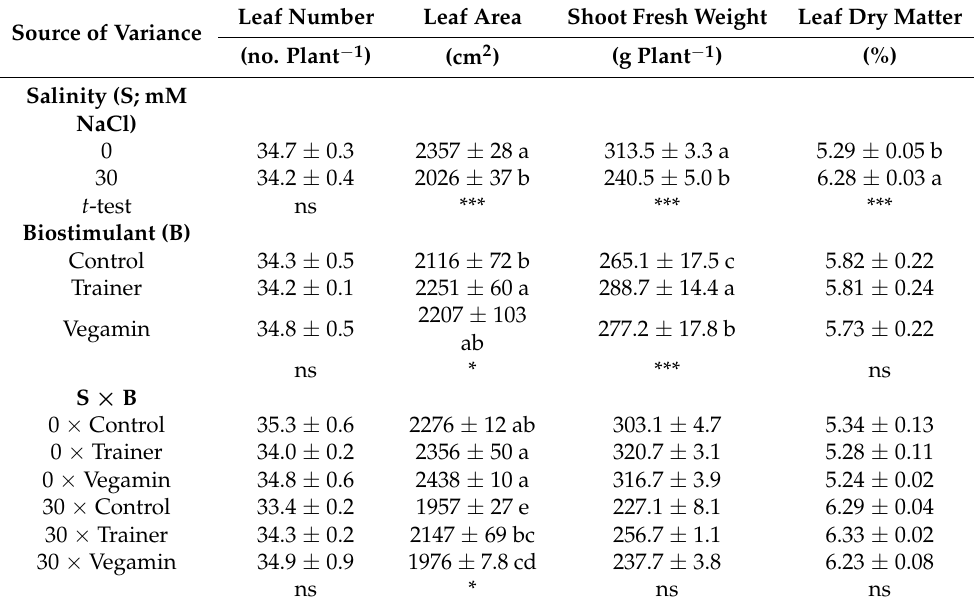
Table 1. Yield and yield parameters of lettuce plants as affected by salinity and biostimulant application. Leaf Number Leaf Area Shoot Fresh Weight Leaf Dry Matter Source of Variance (no. Plant − 1 ) (cm 2 ) (g Plant − 1 )